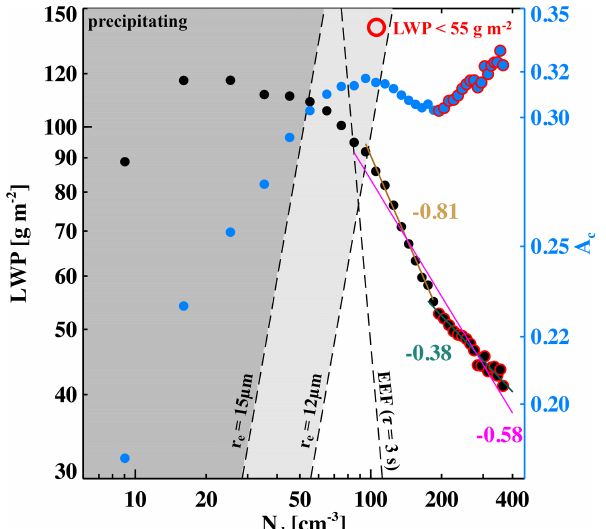
Figure 2. Mean liquid water path (LWP; black dots) and cloud albedo ( A c ; blue dots) of each cloud droplet number concentra- tion ( N d ) bin (bin size of 10cm − 3 ). Values are shown on loga- rithm scales. Isolines of evaporation–entrainment feedback (EEF; phase relaxation timescale of 3s); effective radius ( r e ) of 12 and 15µm (commonly used measures of precipitation) based on an adi- abatic condensation rate of 2 . 14 × 10 6 kgm − 4 ; shades of gray back- ground colors represent a general indicator of likelihood of precipi- tation; bin-mean LWPs less than 55gm − 2 are highlighted by red circular outlines. The linear regressed slopes of ln(LWP)–ln( N d ) for all non-precipitating clouds (magenta), non-precipitating clouds with LWP > 55gm − 2 (brown), and non-precipitating clouds with LWP < 55gm − 2 (green) are also indicated.